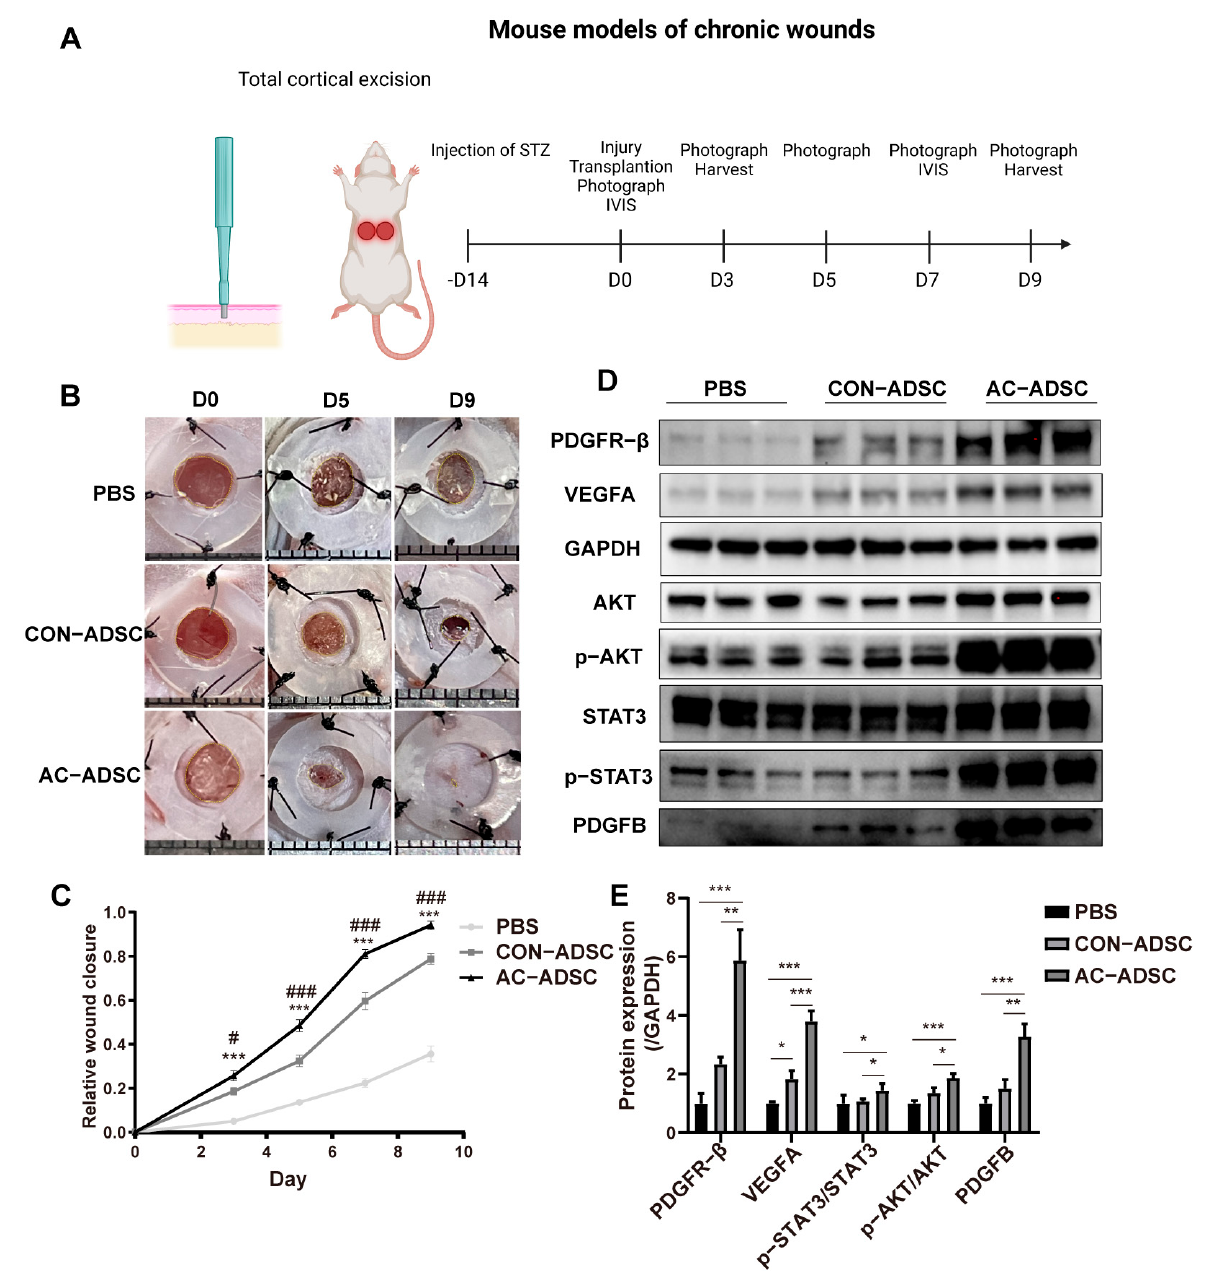
Figure 6. PDGFR −β overexpressed ADSCs accelerated wound healing in diabetic mice. ( A ) Sche- Figure 6. PDGFR– β overexpressed ADSCs accelerated wound healing in diabetic mice. ( A ) matic view of the experiments performed on a mouse model of chronic wounds. ( B ) Representative